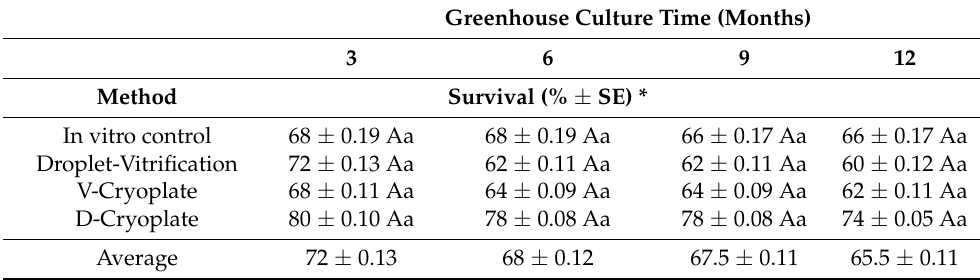
Table 1. Comparison of survival between in vitro controls and cryo-derived plants of Vanilla planifolia during greenhouse